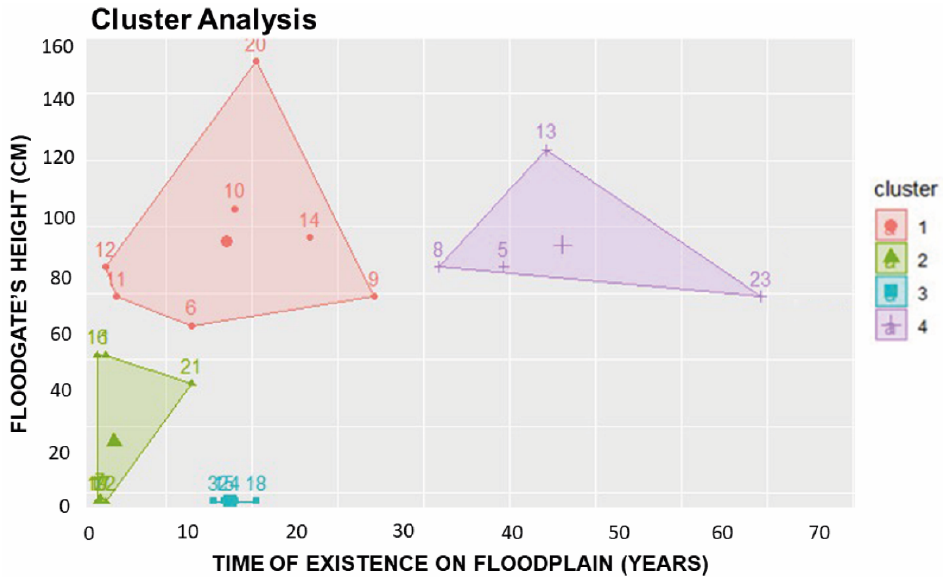
Figure 4. Cluster analysis of ideal types of society.